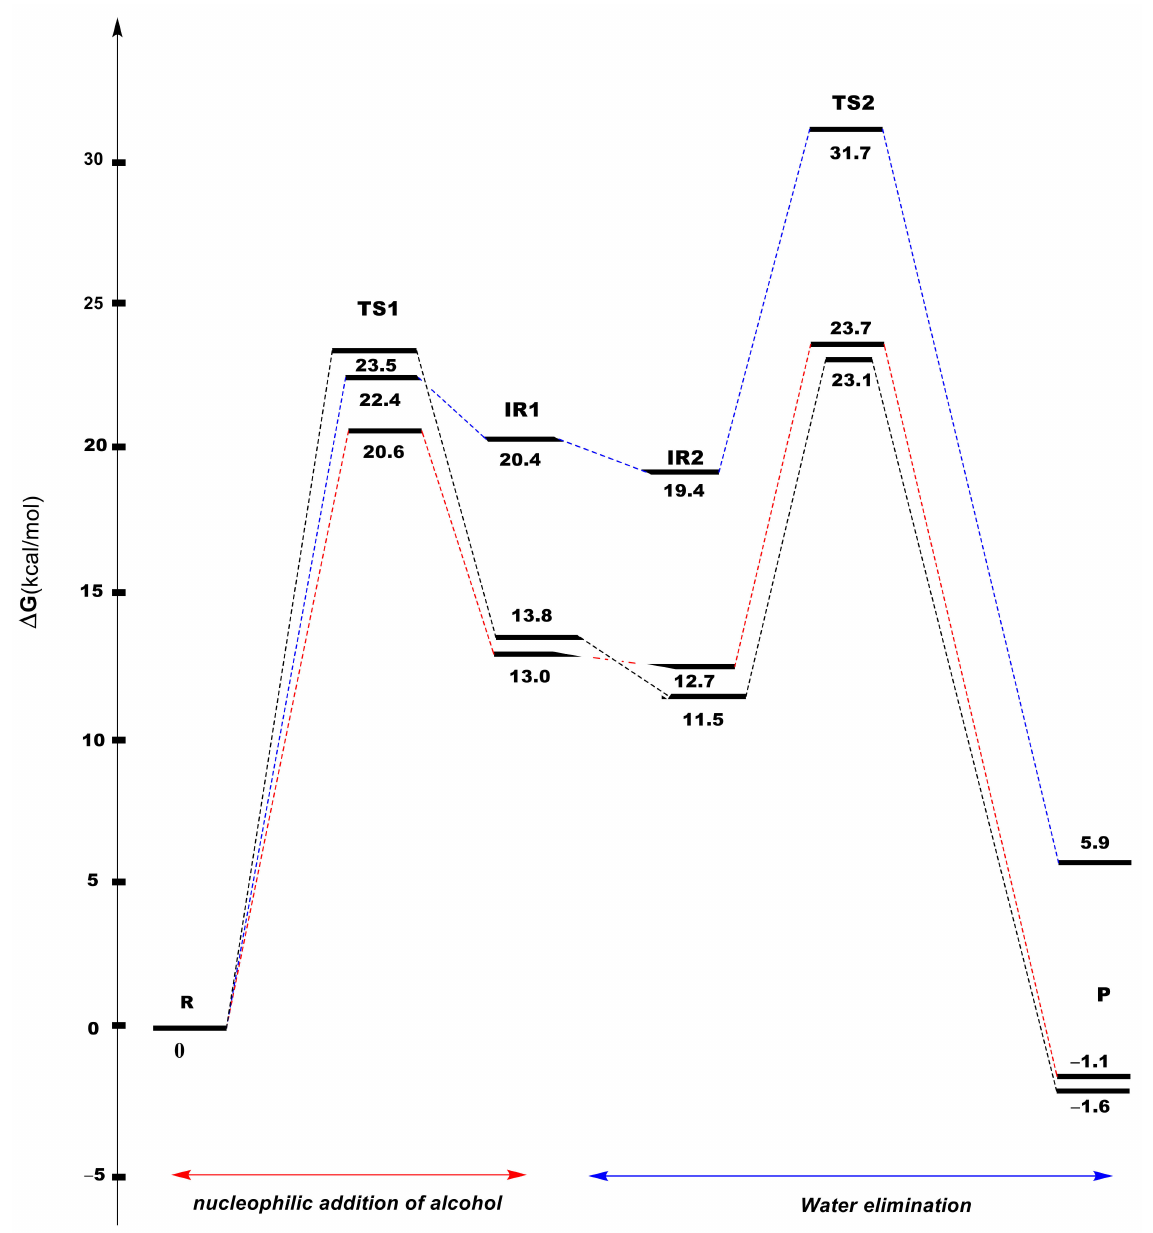
Figure 5. Comparison between the energy profiles for Bachmann–Frapper’s reaction mechanism computed for betaines 1 (blue curve), 2 (black curve) and 3 (red curve). Free enthalpies are given relative to the pre-reacting complex (betaine + glycerol + 2